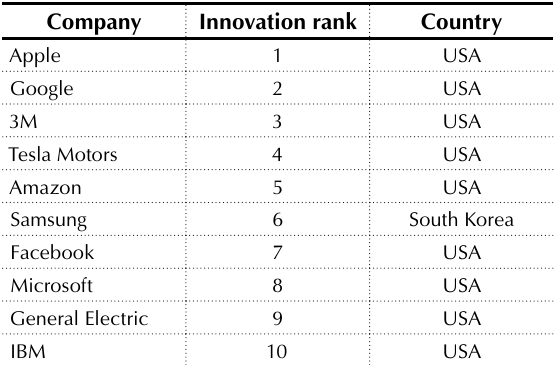
Source: Strategy&